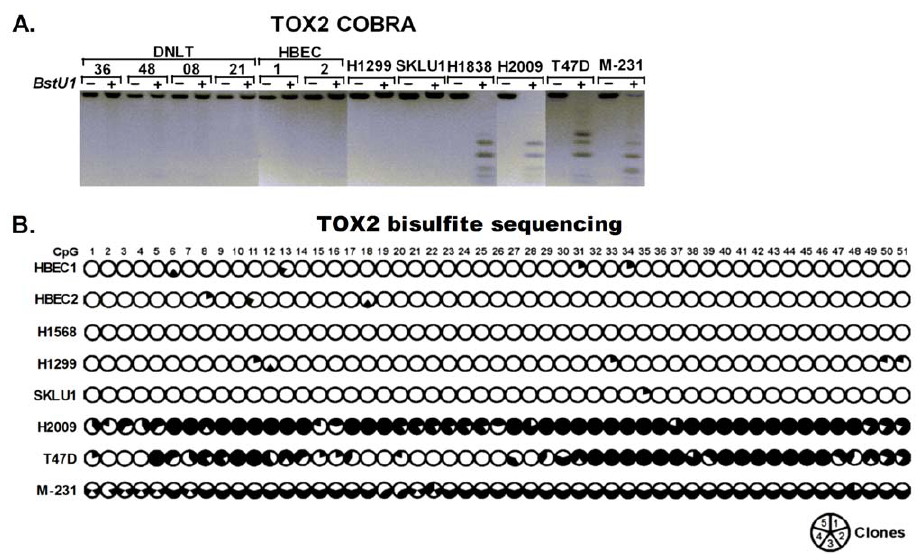
Figure 1. Methylation of TOX2 promoter CpG island. A ) Combined bisulfite modification and restriction analysis (COBRA) depicts methylation of TOX2 promoter CpG island in normal and cancer samples. Complete, partial, or no methylation could be seen from digestion of all, some, or none of the PCR products in the presence of the BstU1 ( + ) enzyme compared to no enzyme ( 2 ) control. MDA-MB-231 and MDA-MB-435 in all the figures are abbreviated as M-231 and M-435, respectively. B ) Bisulfite sequencing was used to validate methylation results obtained through COBRA and MSP assays and to determine the degree and distribution of methylation at 51 CpG sites across TOX2 promoter CpG island. Five clones were sequenced per sample and methylation status of each clone (1/5 th of a circle) at the specified CpG site is shown as methylated (filled) or unmethylated (open).